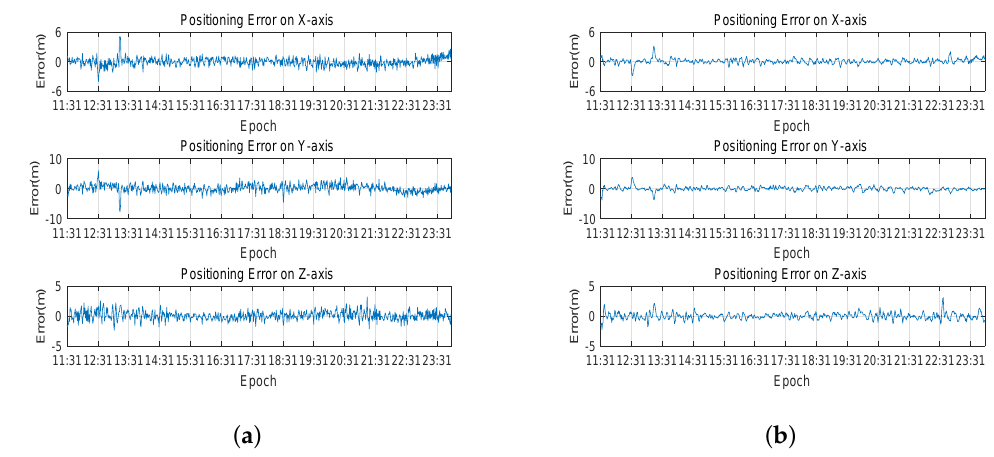
Figure 13. Result of LSTM-based error correction method on the three axes: ( a ) positioning error of WLS–LSTM; and ( b ) positioning error of